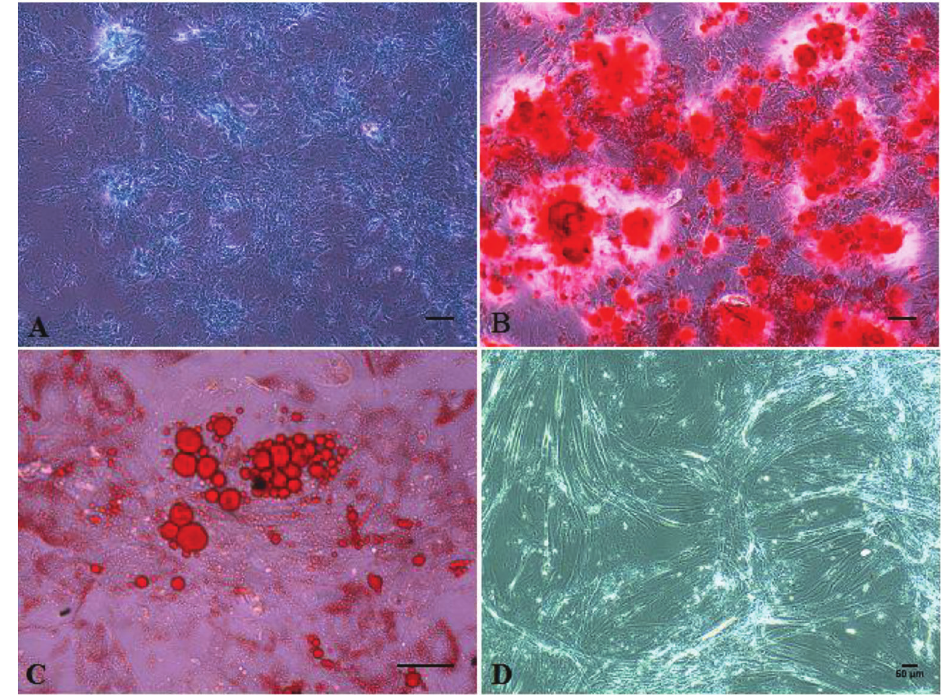
Figure 1. Differentiation of the human adipose derived stem cells. A , Condrogenic differentiation with Alcian Blue dye; B , osteogenic differentiation with Alizarin Red dye; C , adipogenic differentiation with Oil Red dye; D , non-differentiated cells not submitted to dying with typical morphology of mesenchymal stem cells. Images A , B and D with 200 (cid:1) magni fi cation and image C with 400 (cid:1) magni fi cation. Scale bars: 50 m